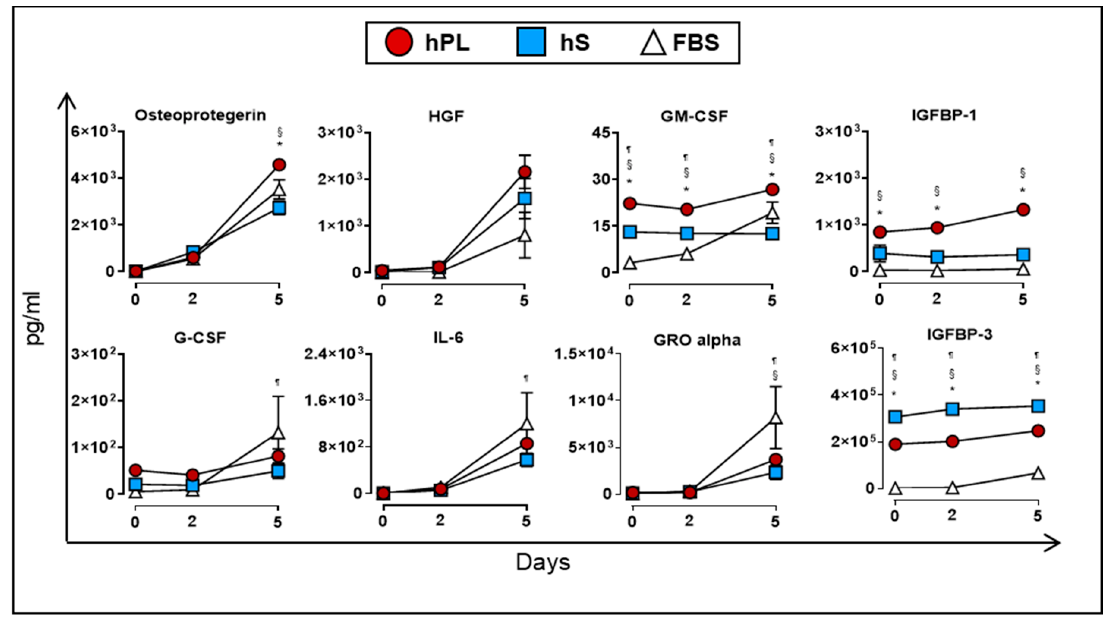
Figure 8. Cytokines and growth factors secreted by WJ-MSC ( n = 3 donors) cultured in hPL ( n = 4), hS ( n = 3) and FBS ( n = 1) and detected in supernatants at day 0, 2 and 5. Data are represented as mean of concentration ± SD. * p < 0.05 hLP vs. hS, ¶ p < 0.05 FBS vs. hLP and § p < 0.05 FBS vs. hS, analyzed by Tukey’s test.